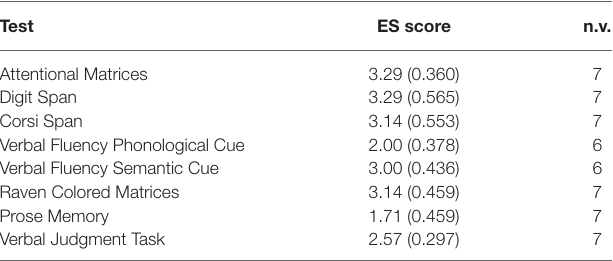
Test ES score n.v. Attentional Matrices